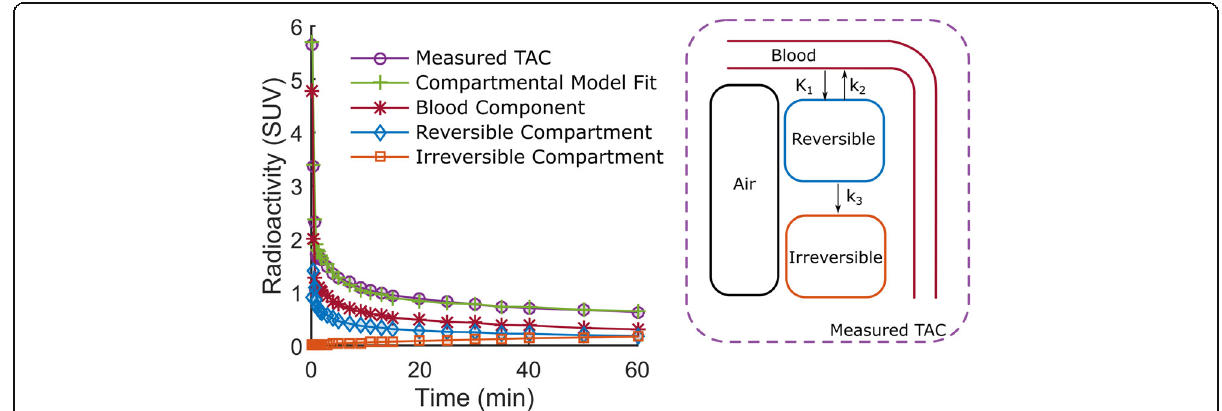
Fig. 3 Left : representative TAC of a HV subject and estimated components obtained using the qABL method. Right : graphical representation of the different components involved in the qABL method: air, blood and tissue (tissue being modelled by an irreversible 2TC model for 18 F-FDG)